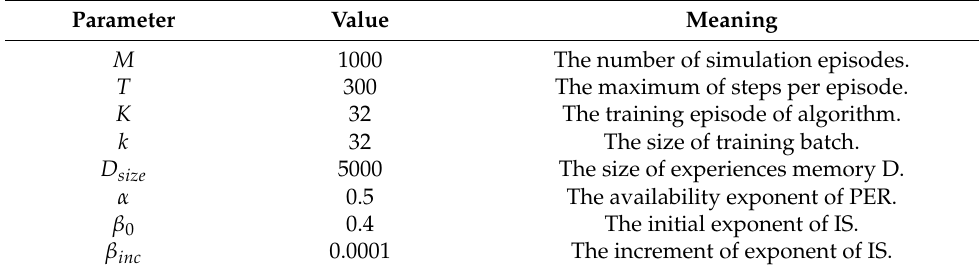
Table 2. The parameters assignment of algorithm.